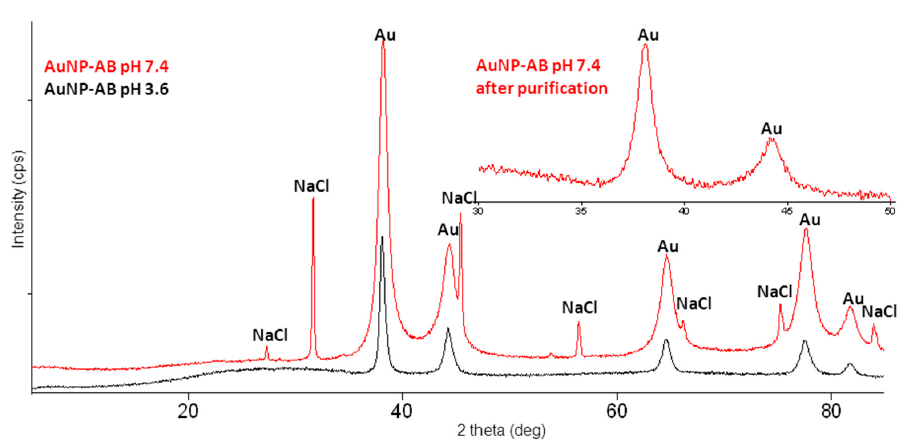
Figure 7. Diffractograms of the AuNPs–AB conjugates obtained in pH 3.6 and 7.4. Insert: a diffractogram of the nanoparticle obtained in pH 7.4 after purification in the range of 30–50 ◦